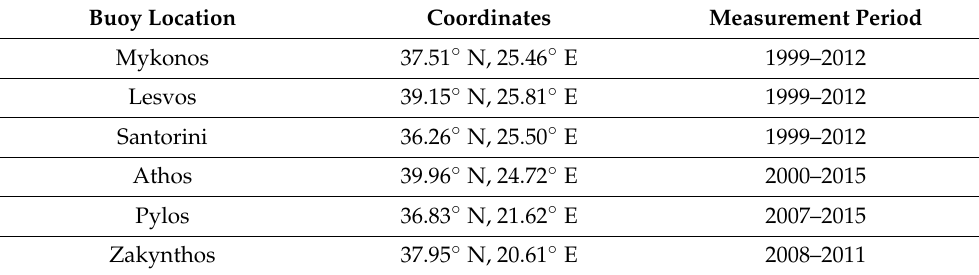
Table 1. POSEIDON buoy locations and measurement